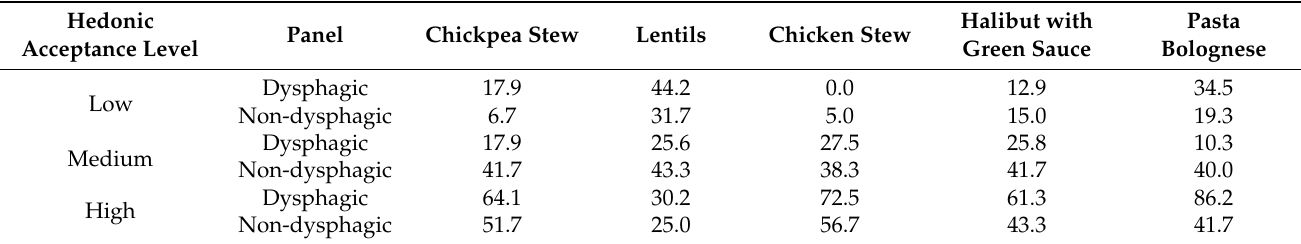
Table A1. Proportion of judges who selected each hedonic acceptance level for each texture-modified dish. Hedonic Acceptance